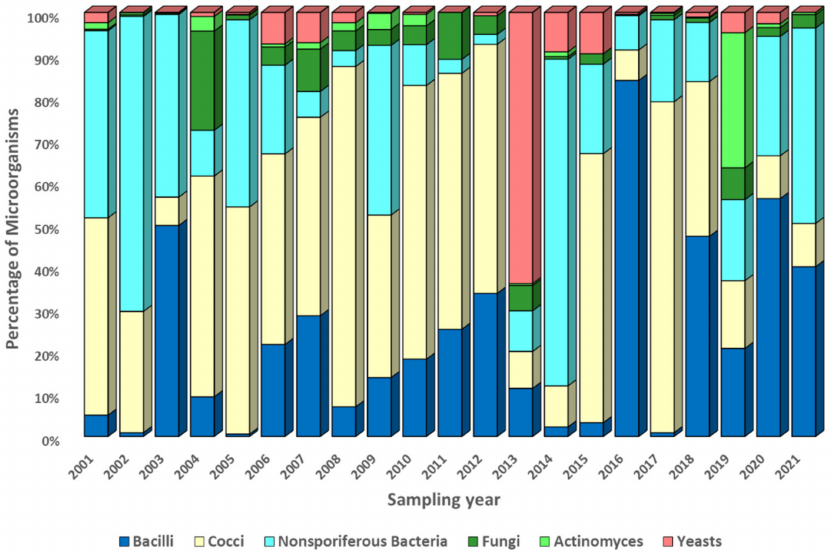
Figure 8. The average annual variability of the ratio of culturable microorganisms in samples taken on the territory of the Vector’ site. Explanation in the